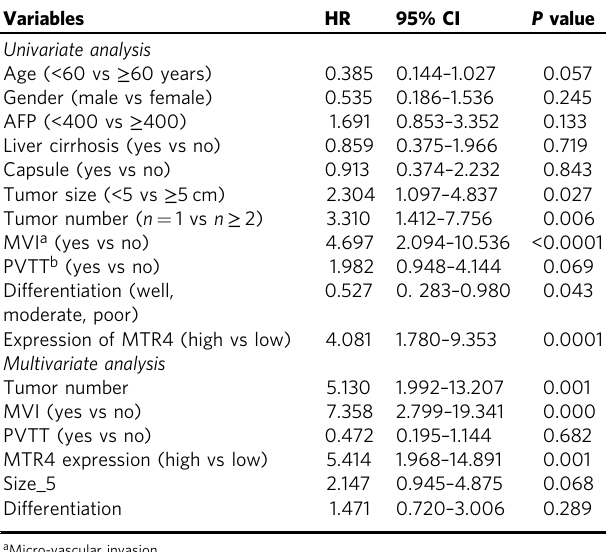
Table 1 Univariate and multivariate Cox regression analyses of recurrence-free survival for MTR4 ( n =